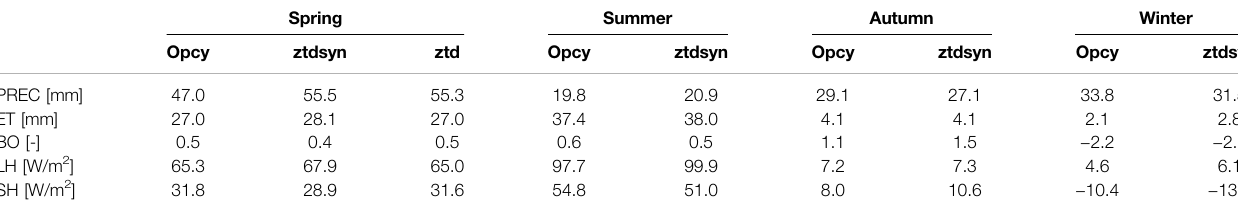
TABLE 4 | Water cycle and energy budget components from simulations without assimilation (opcy), best assimilation setup (ztdsyn) and assimilating ZTD only (ztd, only spring) for our four episodes in every season considering the domain mean.